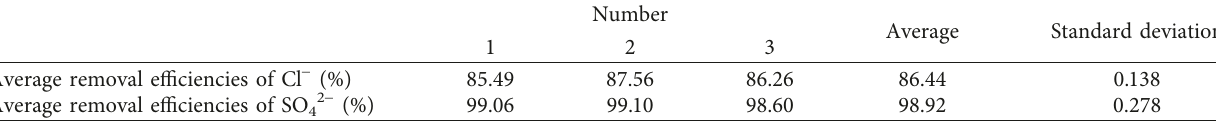
Table 2: Results of Cl